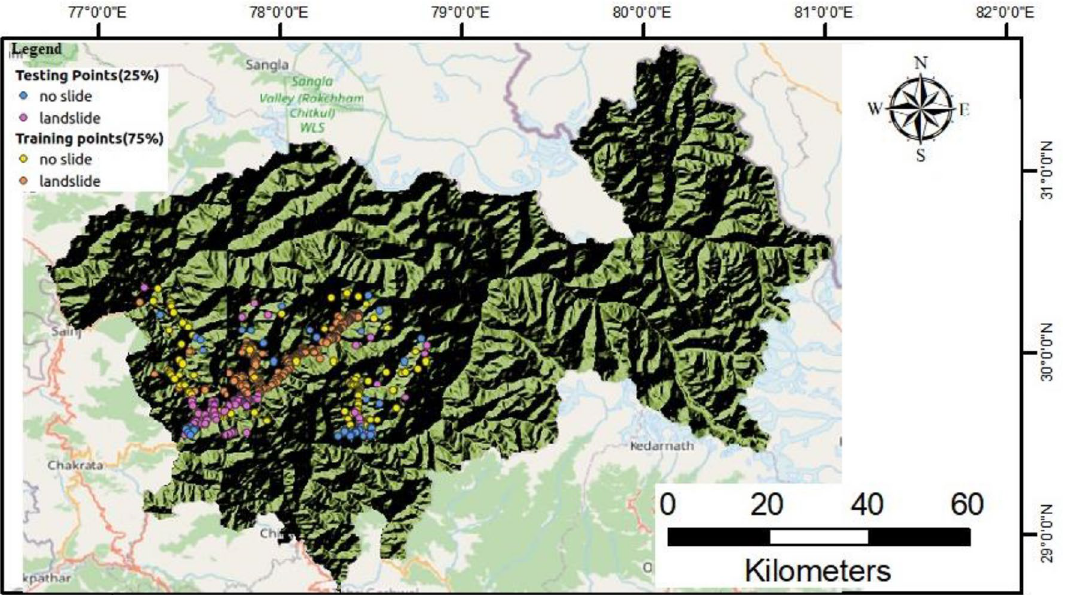
Figure 3. Partition of the landslide and non-landslide locations into training and testing data points with in ratio of